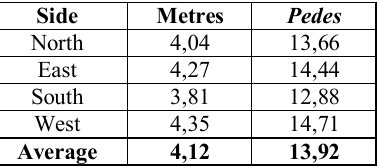
Table 1. Internal best-fitting circumferences extracted from Geomagic Design X.